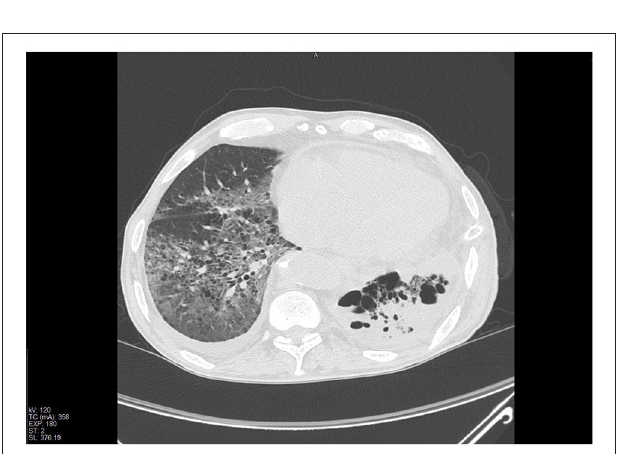
FIGURE 2 | Chest CT-scan showing the presence of extensive pulmonary infarction in the residual